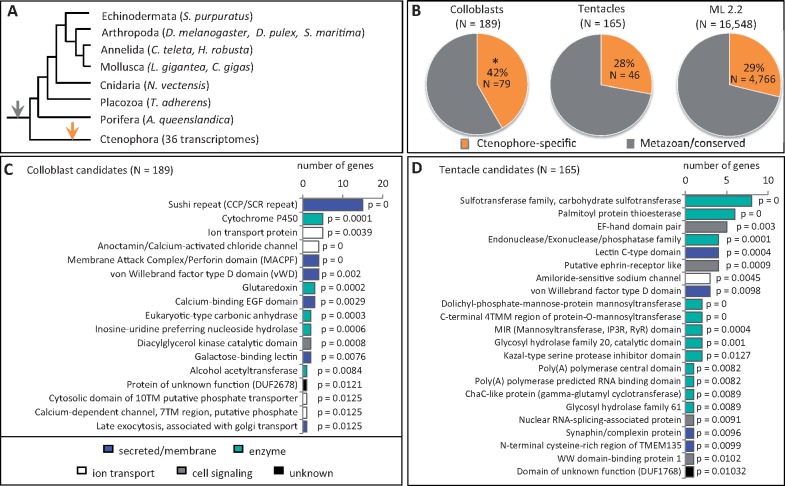
Ontology of candidate genes. (A) Cladogram of the taxa used to identify ctenophore-specific genes. Genes with significant BLAST hits (E ≤ 1e–02) to taxa other than Ctenophora are assumed to have been present in the common ancestor of all animals (grey arrow). Genes lacking significant hits to other metazoan taxa are assumed to have originated after ctenophores diverged from the rest of animals or to have been lost in the stem lineage giving rise to the rest of animals (orange arrow). (B) Ctenophore-specific genes (orange) are significantly enriched in the set of late-expressed colloblast candidates (P = 0.0007), but comprise similar proportions of the tentacle candidate genes and complete set of protein models from Mnemiopsis leidyi (ML 2.2). (C, D) Overrepresented annotations from colloblast and tentacle candidates, relative to ML2.2 protein model annotations.